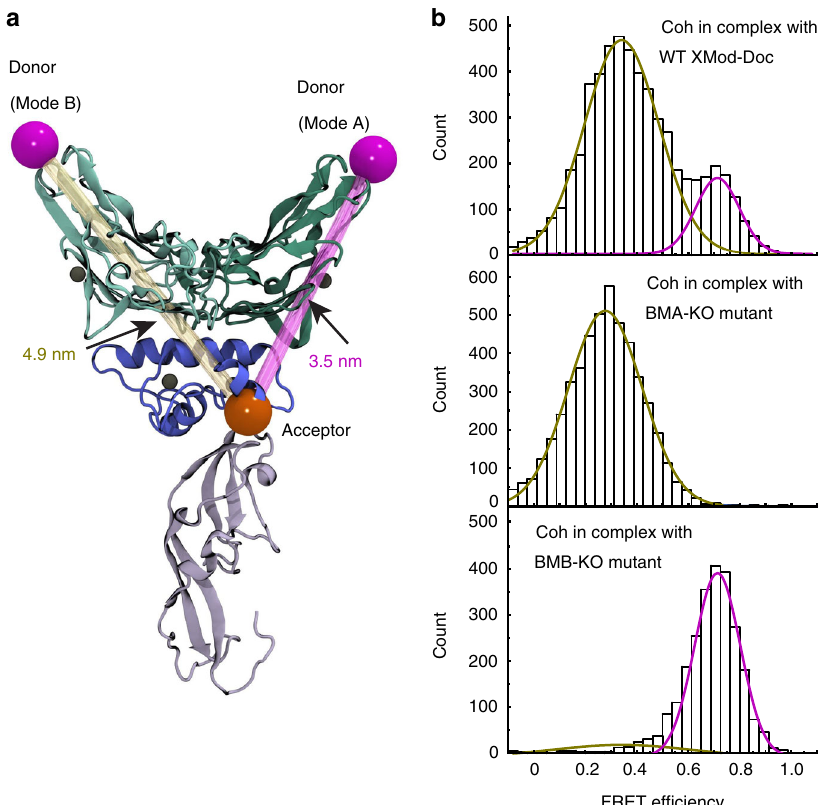
Fig. 4 Dual binding modes are observed by smFRET. a The C-terminus of Coh (position 154) was labeled with the FRET donor Cy3b (shown in magenta) while the C terminus of the XMod-Doc (position 199) was labeled with the FRET acceptor AF647 (shown in orange). The donor – acceptor distance was smaller in binding mode A (3.5 nm) than the binding mode B (4.9 nm), giving rise to a higher FRET ef fi ciency when the complex formed in binding mode A. b FRET ef fi ciency histograms measured using Cy3b-labeled WT XMod-Doc (top), BM A -KO (middle), or BM B -KO (bottom) complexed with AF647-labeled Coh. Ef fi ciency histograms were fi tted with single or double Gaussian